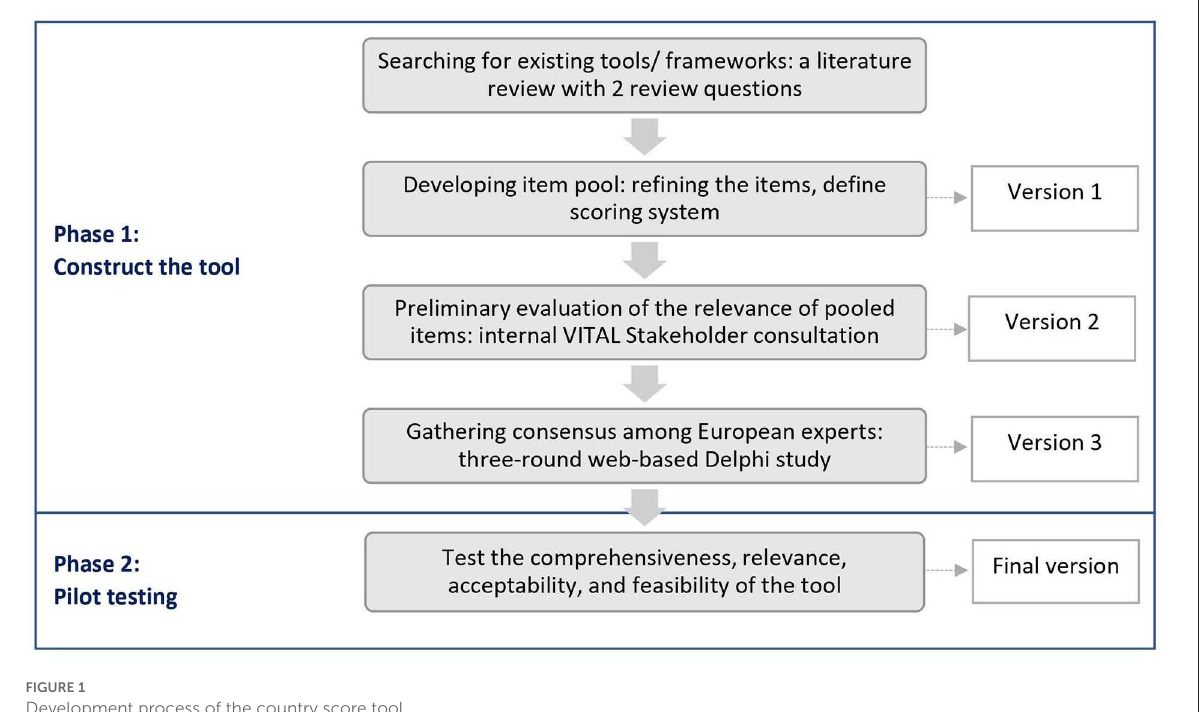
FIGURE1 Development process of the country score